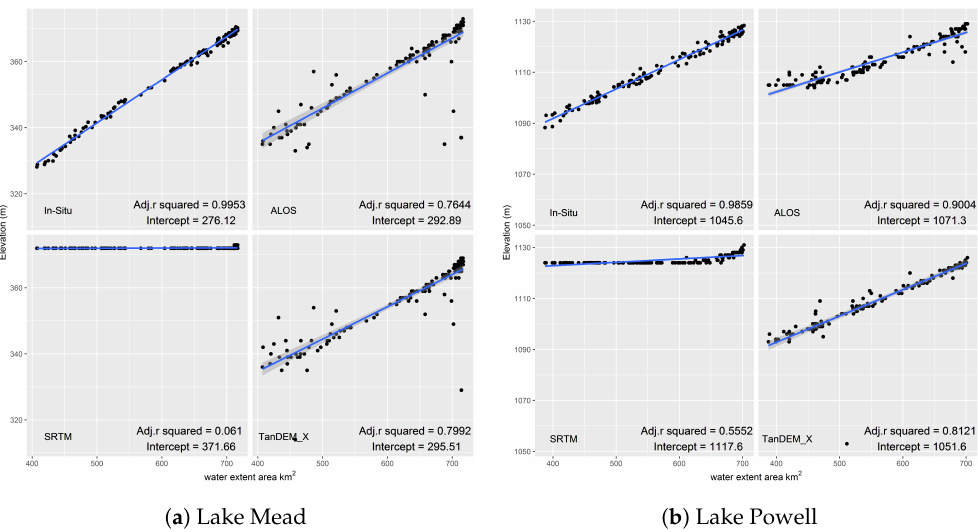
Figure 4. Linear hypsometric relationship between GSW-MWH areas and median DEM